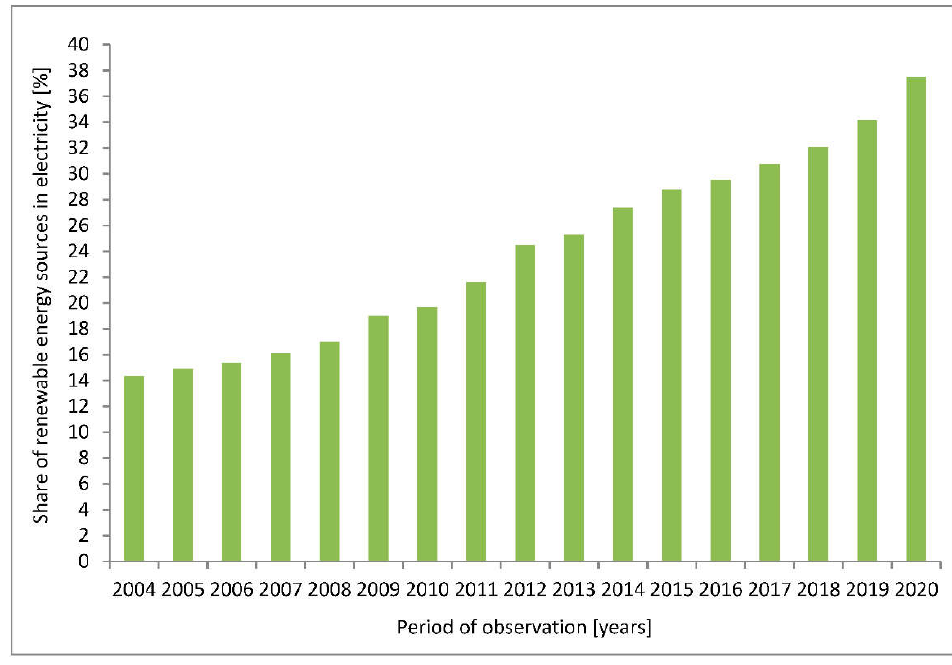
Figure 1. Share of renewable sources in electricity generation, on the basis of [10].